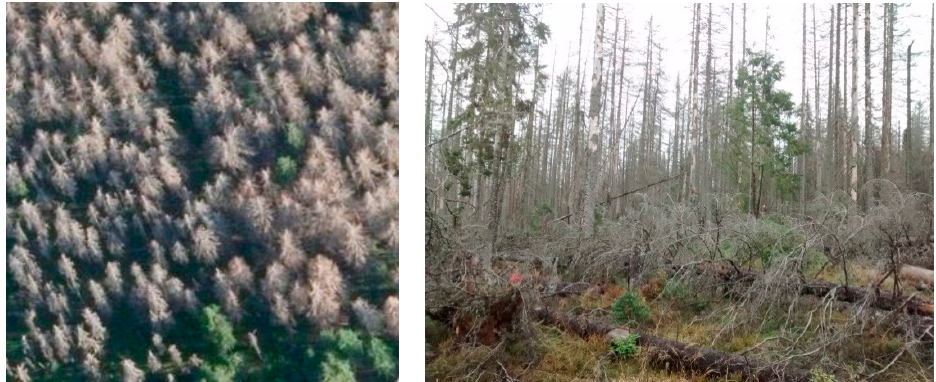
Figure A2. Aerial photo and photo of class A2.